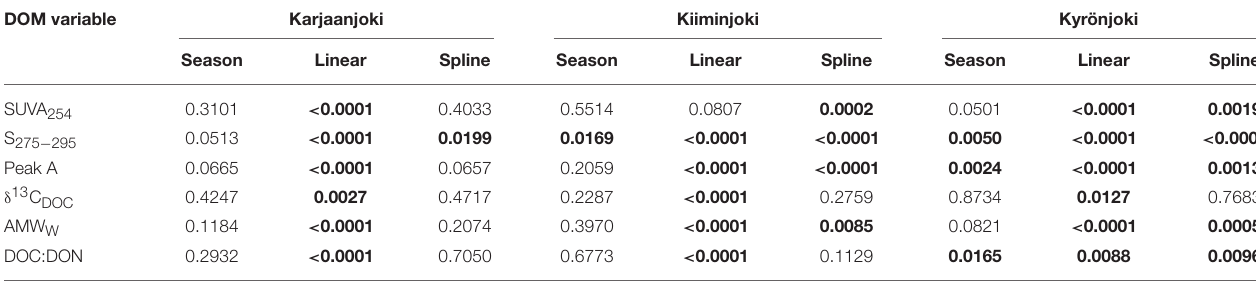
TABLE 2 | Significance of the three GAM components for explaining variations in DOM quality variables in the three estuaries. DOM